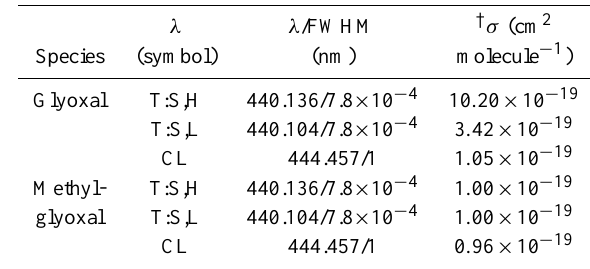
Table 1. Summary of the wavelengths and the corresponding optical cross-section for their respective